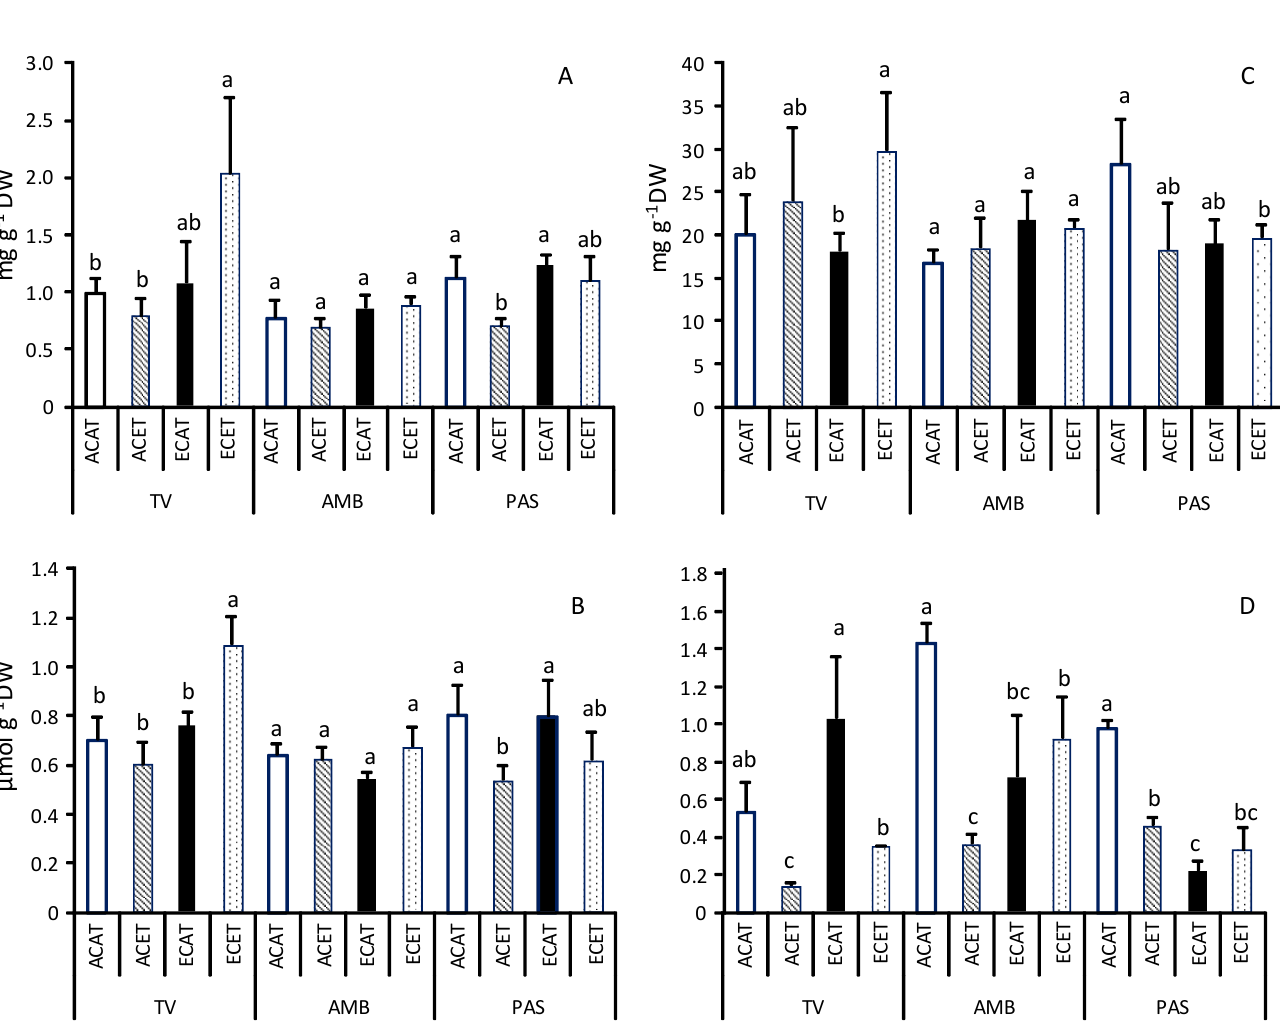
Figure 2. Concentrations of total soluble proteins (TSP) (mg g − 1 DW) ( A ), proline ( µ mol g − 1 DW) ( B ), total soluble sugars (TSS) (mg g − 1 DW), ( C ) and starch (mg g − 1 DW) ( D ) in leaves of grapevine Tinto Velasco (TV), Ambrosina (AMB), and Pasera (PAS) grown at (1) ambient (~400 µ mol mol − 1 ) CO 2 concentration (AC) and ambient temperature (AT) (ACAT); (2) AC and elevated (T + 4 ◦ C, ET) temperature (ACET); (3) elevated CO 2 (700 µ mol mol − 1 , EC) and AT (ECAT), and (4) EC and ET (ECET). Bars represent means ± S.E. (n = 3–6). Within each graph and grapevine variety, bars topped by same letter indicate that values do not differ significantly ( p > 0.05). DW = dry weight.